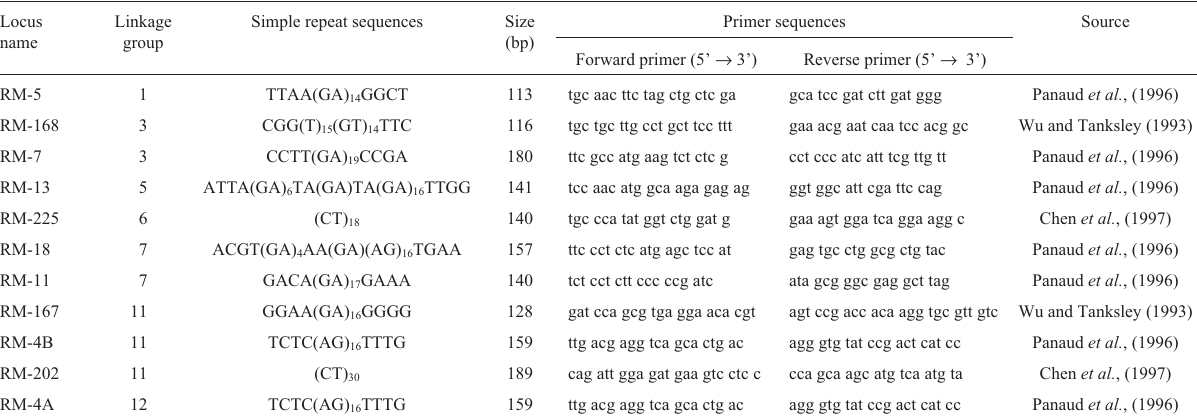
Table 2 - The microsatellite primers used in this study came from a study of polymorphic microsatellite primer pairs from Latin American rice varieties (G. Gallego, personal communication). The size (bp) of the polymerase chain reaction (PCR) product and number of perfect repeats refer to variety IR-36. Ordered by linkage group.